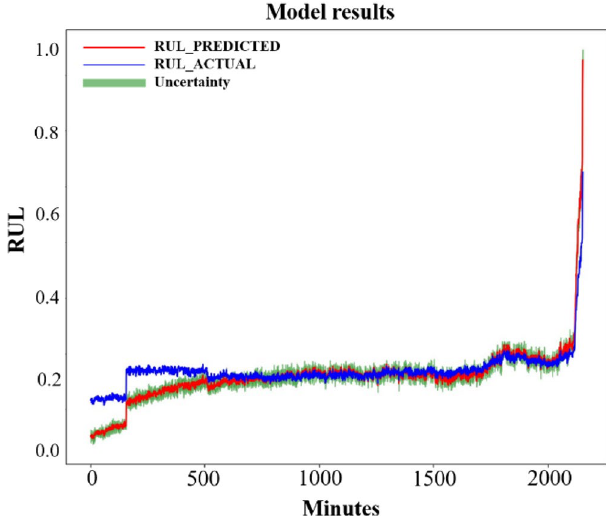
Figure 17. Visualization of retest results using bearing3